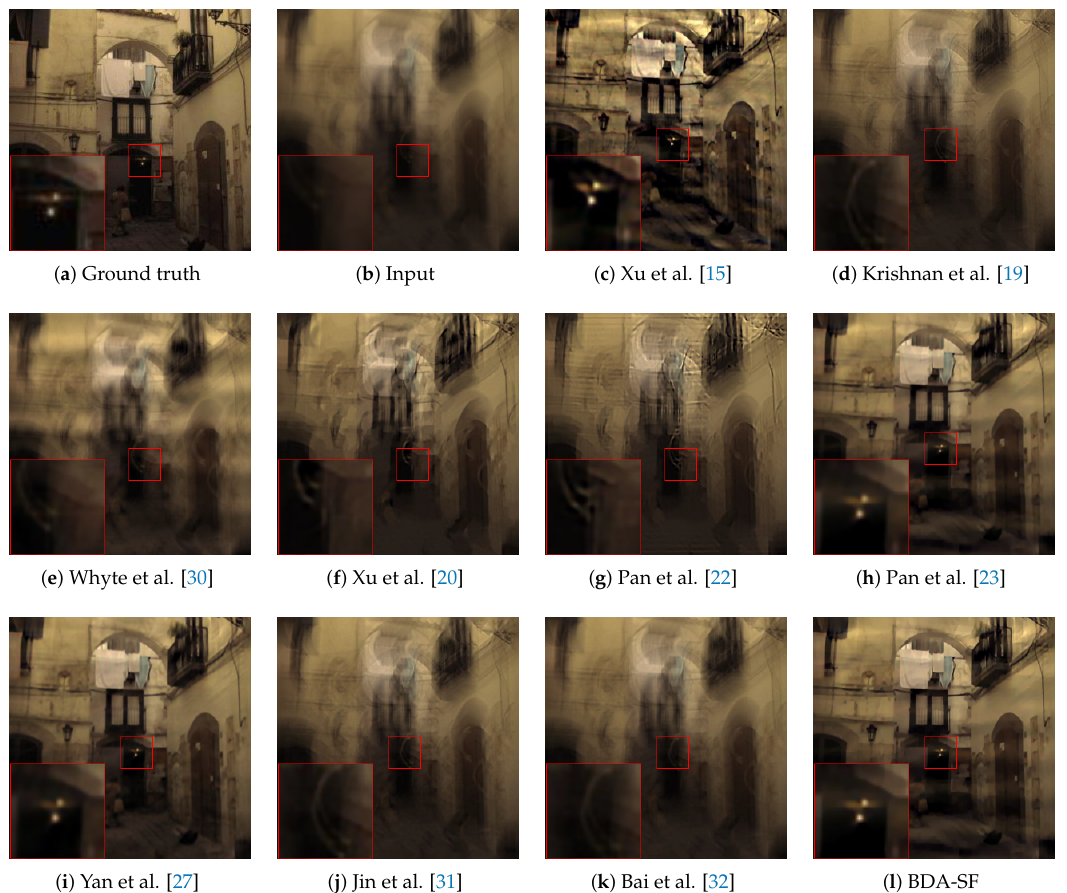
Figure 12. Deblurred results from the dataset [57]. The PSNR and SSIM values are shown in Table 2. BDA-SF has the second highest PSNR and SSIM. The deblurred image estimated by BDA-SF is visually more pleasing. (Best viewed on high-resolution display with